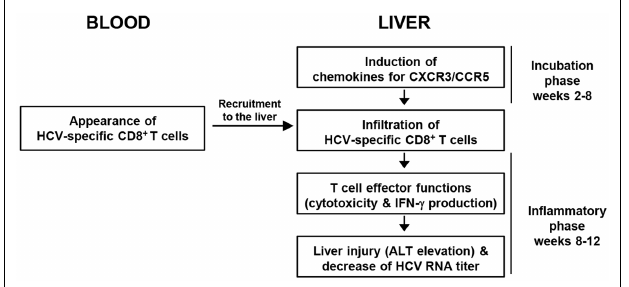
FIGURE 2 | Sequence of events during HCV-specific CD8 + T-cell responses in blood and liver throughout acute HCV infection .